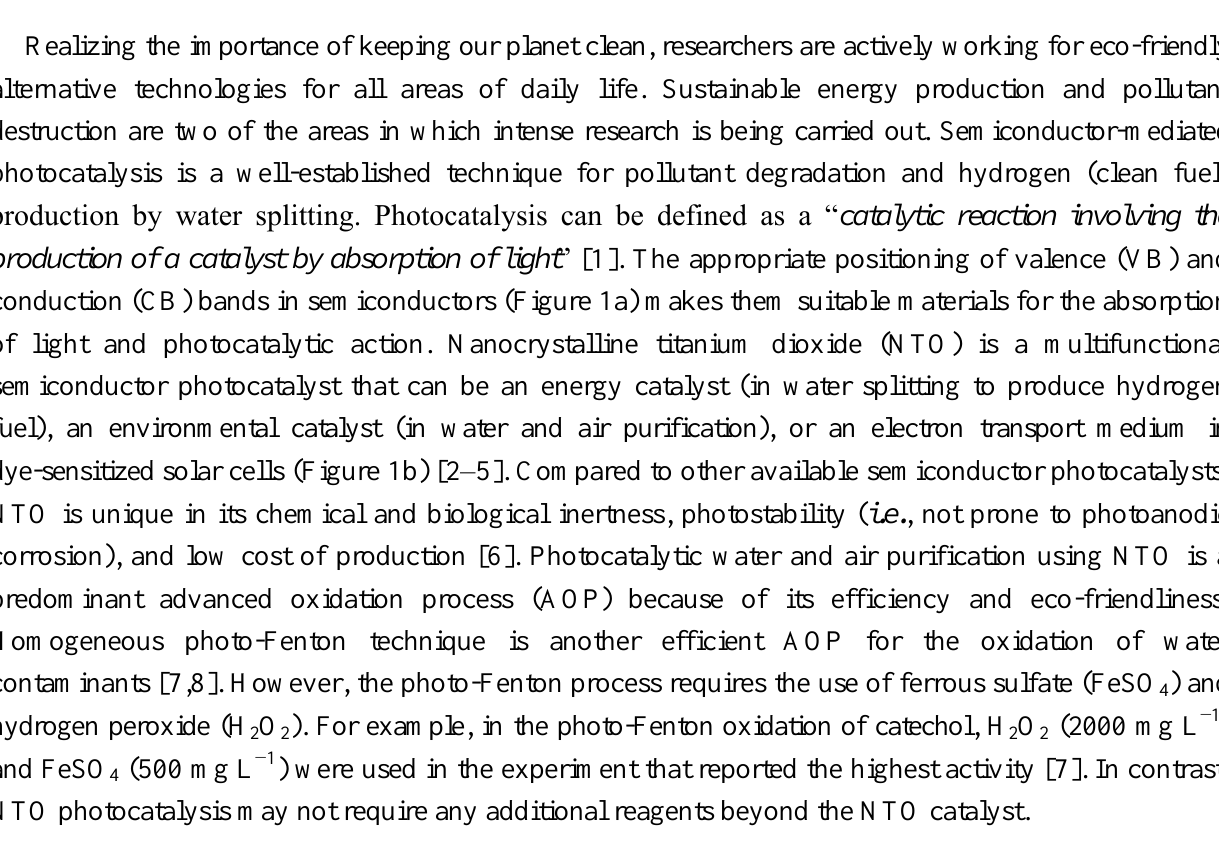
Figure 1. ( a ) VB and CB positions in metals, semiconductors, and insulators; ( b ) Tree diagram showing applications of TiO 2